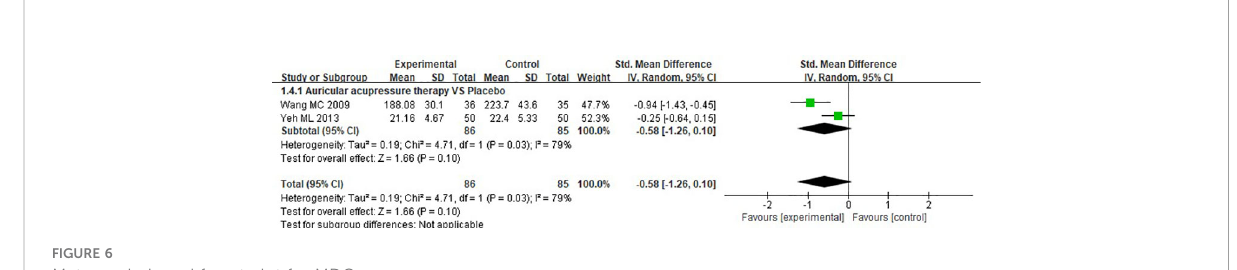
FIGURE 6 Meta-analysis and forest plot for